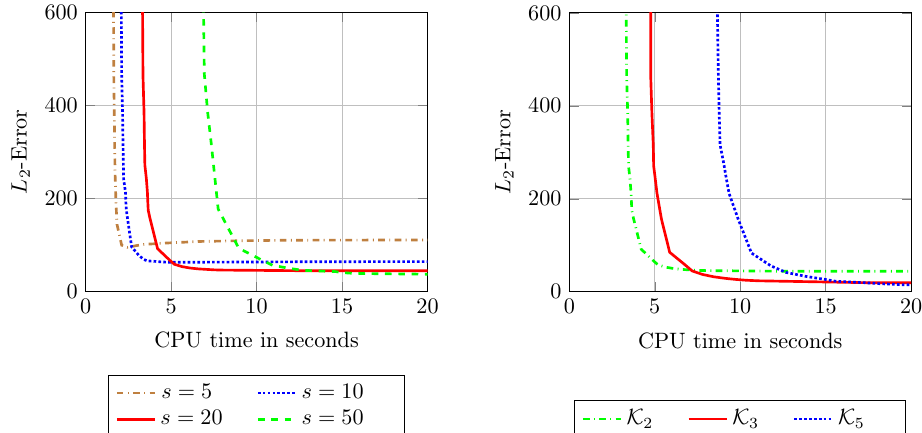
Figure 7. Results of the two-dimensional GES experiment without source: comparison of the L 2 -error and the corresponding CPU time using KSMOR (cid:63) at t F = 2.609 computed with the EE method. Left: KSMOR (cid:63) is applied with q = 2 and a varying size of snapshot data for s = 5,10,20,50 . Right: KSMOR (cid:63) is used by constructing subspaces with s = 20 for q = { } best compromise in performance is achieved with s = 20 and q = 3. Compared to the original KSMOR method (cf. Appendix C.2), the approximations are computed dramatically fast.